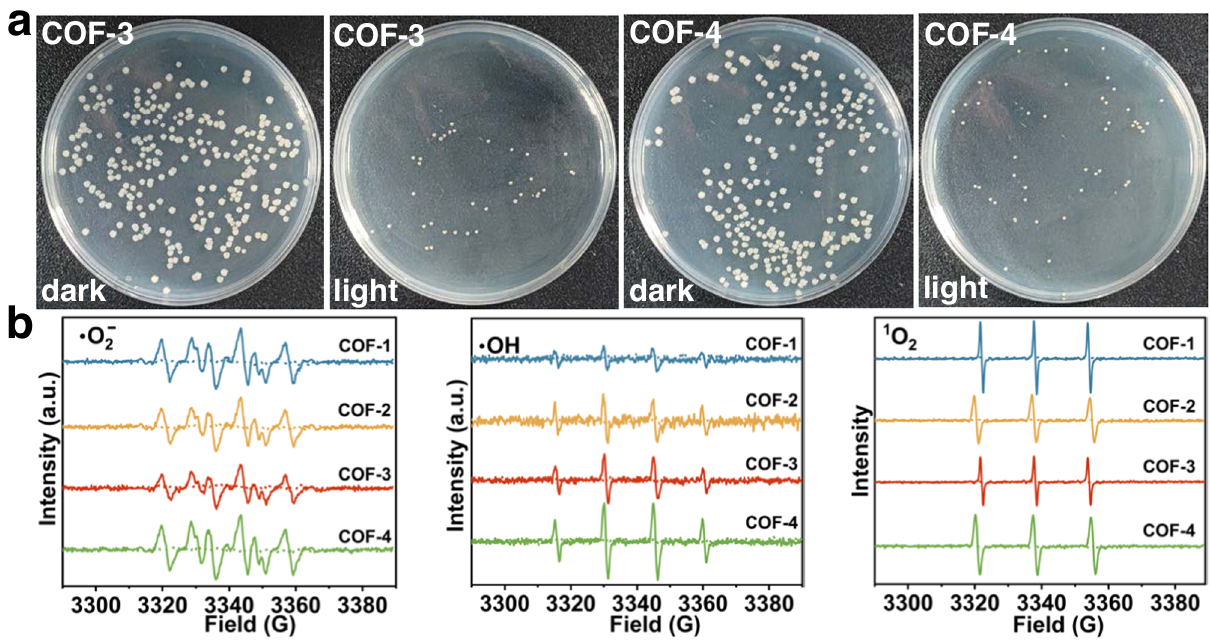
Fig.6|Anti-biofoulingactivityandEPRmeasurements.a Photographsofmarine bacteria colonies after treatment with COF-3 and COF-4 in the dark and under